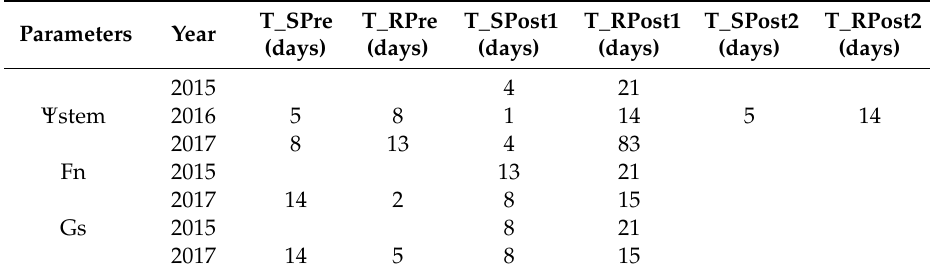
Table 6. Period of time that elapses since each parameter detects water stress in each drying cycle and time that the D treatment takes to